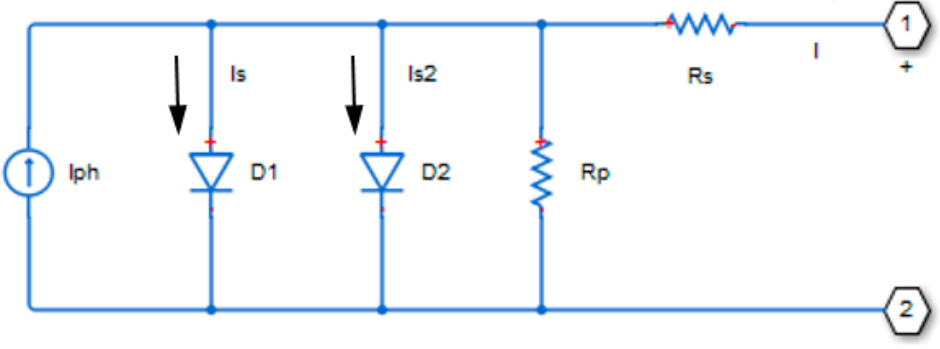
Figure 5. Block diagram of the equivalent circuit used for modeling PV cell in MATLAB.